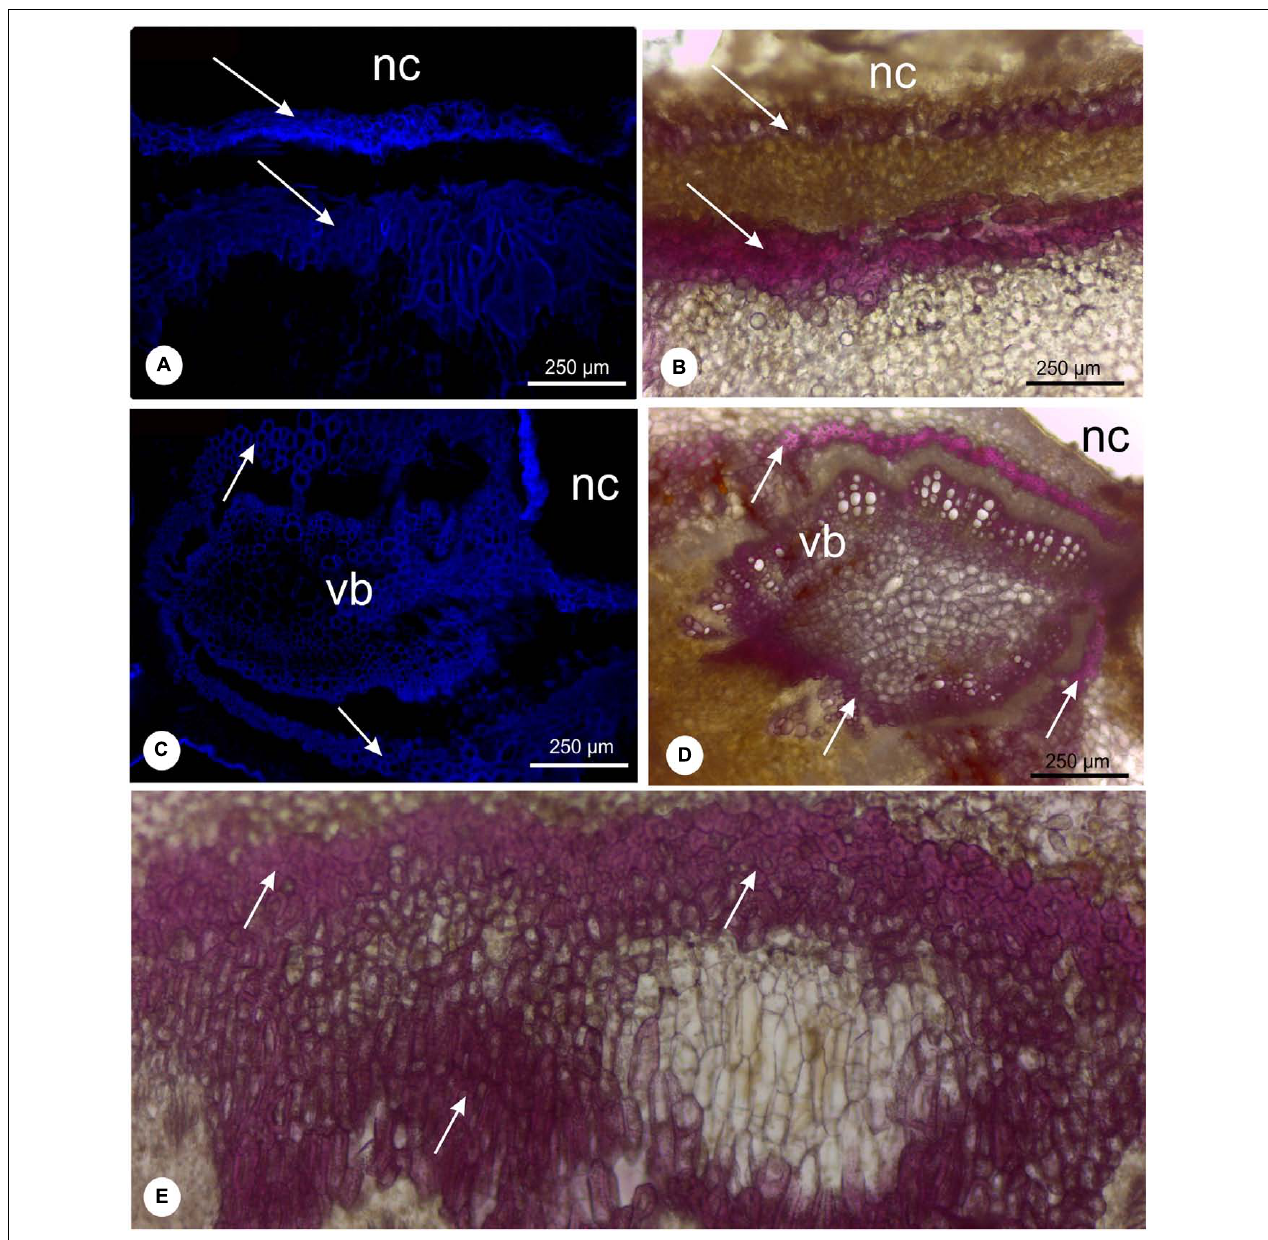
FIGURE 6 | Lignin detection in leaflet galls induced by Bystracoccus mataybae (Eriococcidae) on Matayba guiananeis (Sapindaceae) by fluorescence method with DAPI filter (A,C) and histochemical test with 2% phloroglucinol-HCL (B,D,E) . (A,B) Detail of the ostiole on the abaxial surface of a gall with lignified cells (arrow). (C,D) Vascular bundle adjacent to the nymphal chamber surrounded by fibers (arrows). (E) Intense lignification around the nymphal chamber. nc, nymphal chamber; os, ostiole; vb, vascular